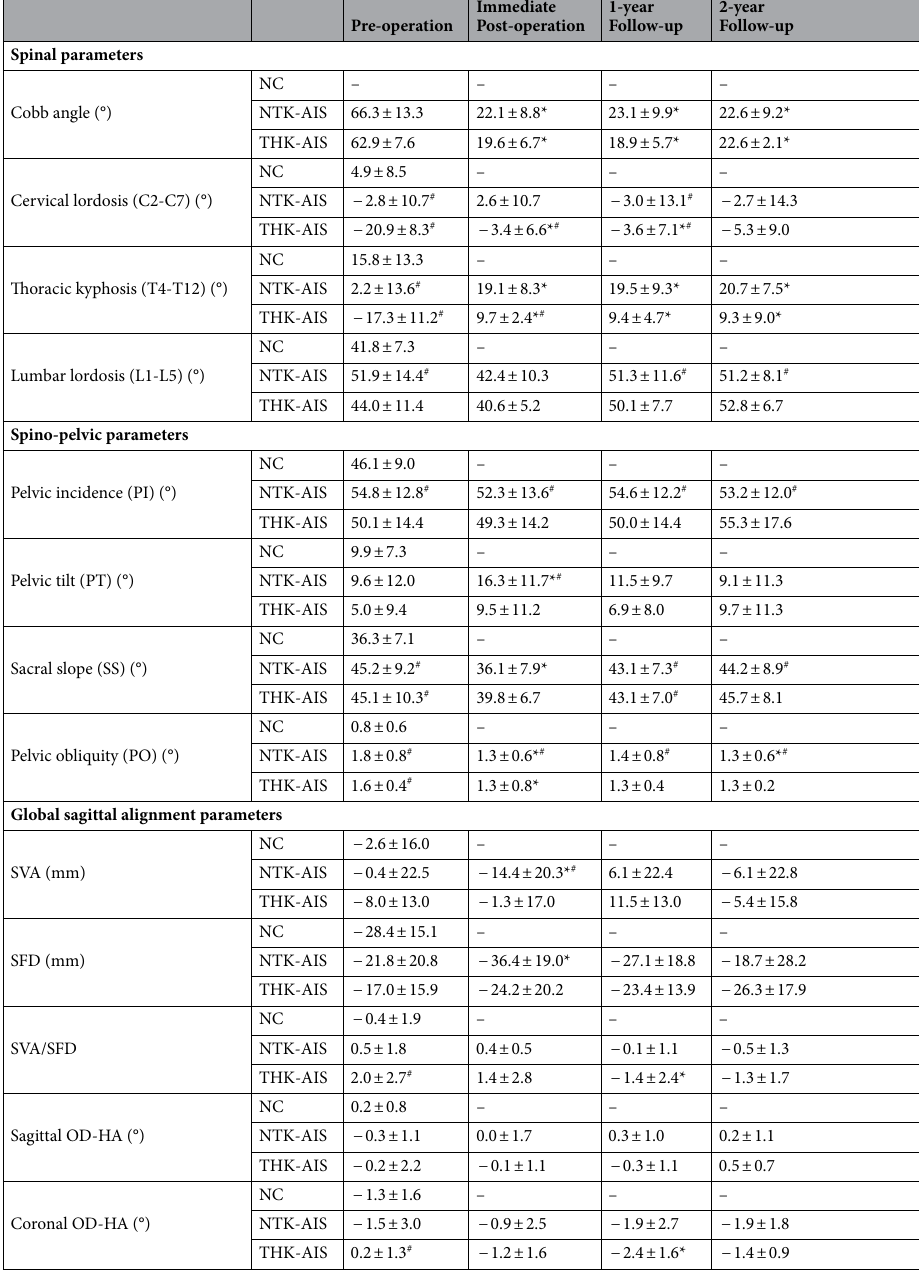
Table 2. Spinopelvic and global sagittal alignment parameters pre-operatively, immediate post-operatively, 1-year and 2-year follow-up AIS subjects and controls. NC asymptomatic controls; NTK normal thoracic kyphosis; THK thoracic hypokyphosis; SVA sagittal vertical axis; SFD , sacro-femoral distance; OD-HA , odontoid-hip axis angle. Data expressed as mean ± SD. * P < 0.05, when compared with AIS at pre-operatively. # P < 0.05, when compared with